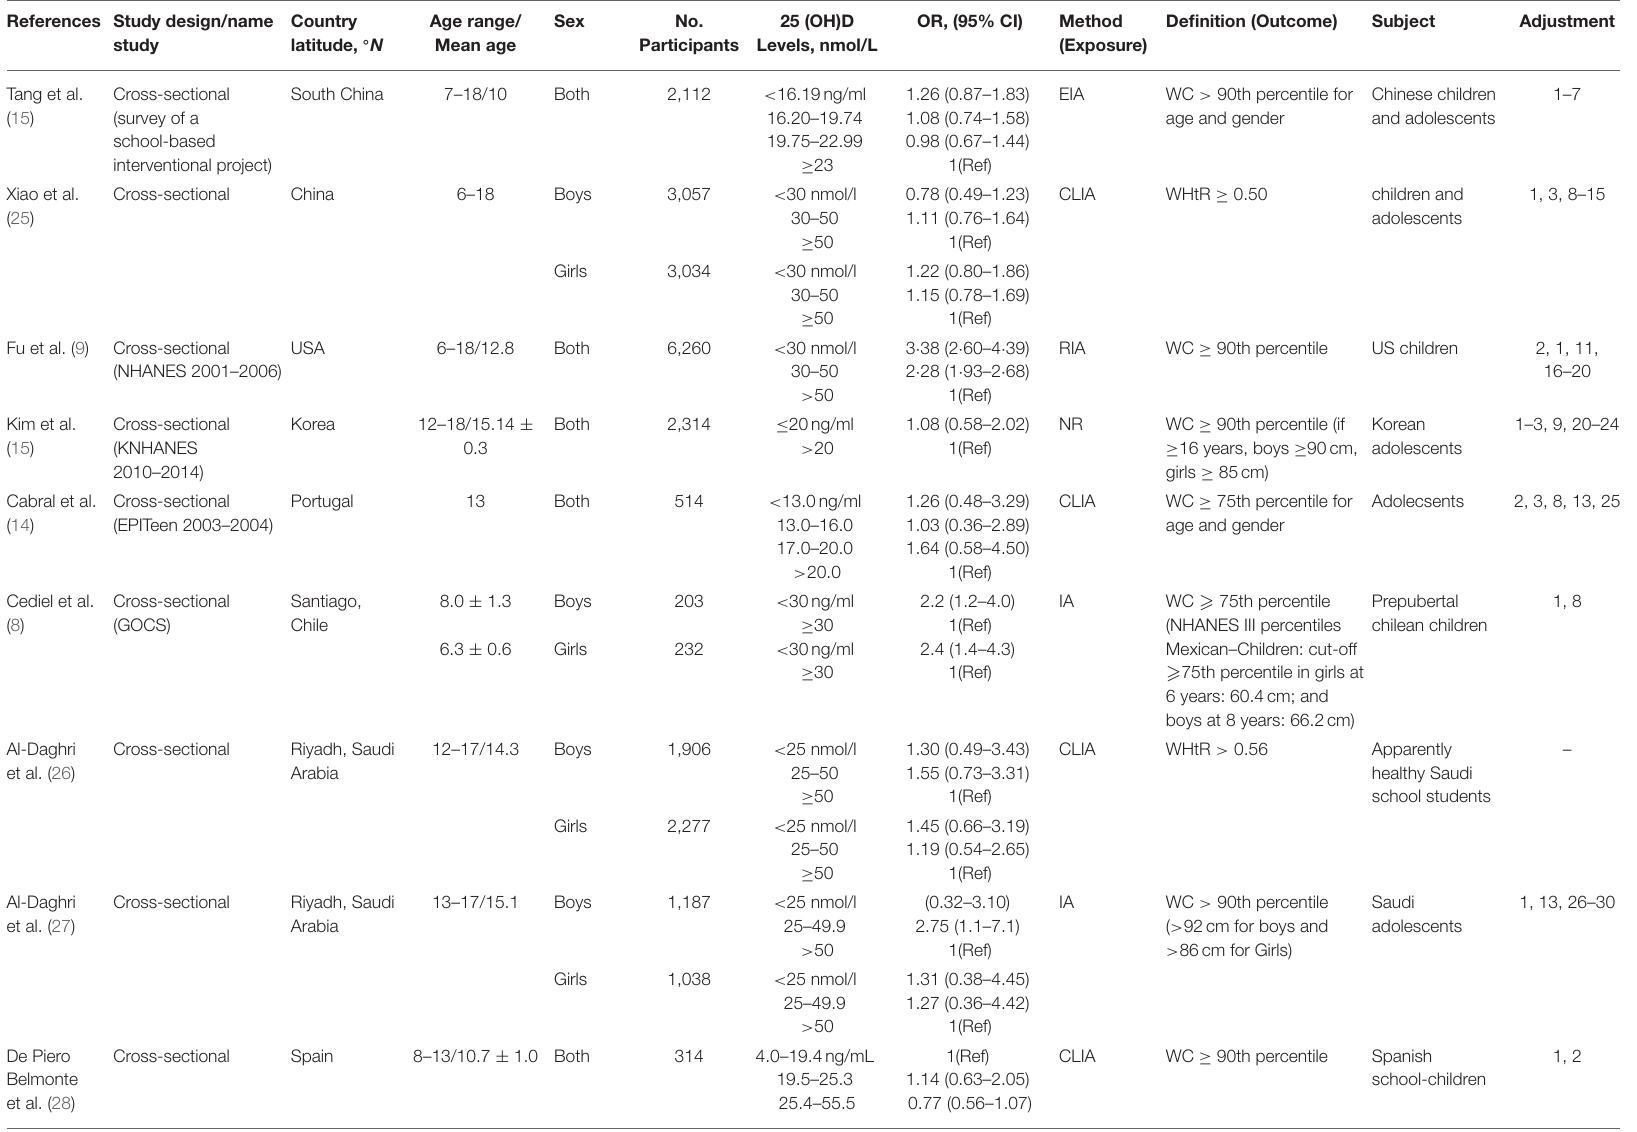
TABLE 2 | Main characteristics of included studies examined the relation between serum vitamin D levels and abdominal obesity in children and